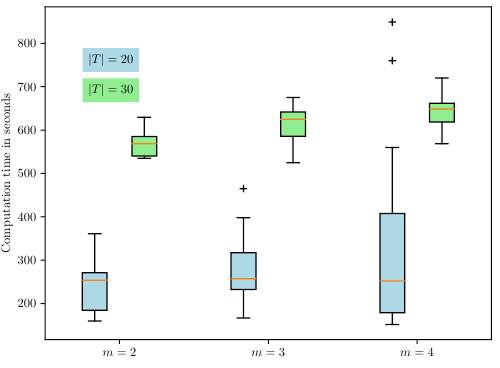
Figure 4. Box plot of the heuristic run times for the second set of instances. The mean run times, in seconds, for m = 2, m = 3, and m = 4 for and ( 327,360 ) ,